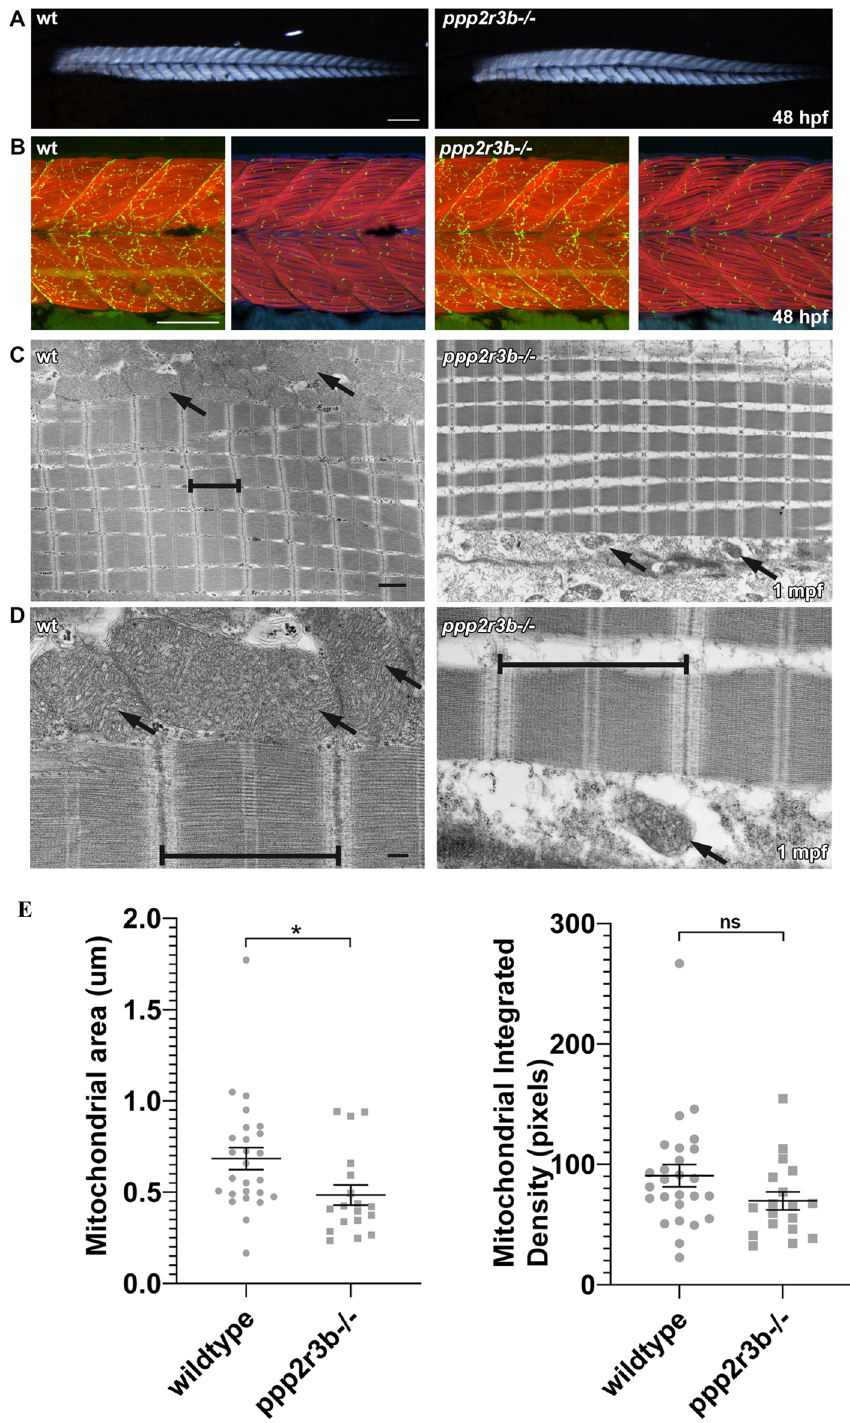
Figure 11. ppp2r3b mutants display abnormal mitochondria formation during adult stages of development, whilst muscle formation remains intact. ( A ) Skeletal muscle birefringence at 48hpf shows comparable muscle integrity between ppp2r3b mutants and wildtype siblings. Scale bar 200 µm. ( B ) Muscle fibres and motor neuron synapses appear normal in mutants compared to wildtype siblings at 48hpf, analysed by staining for F-Actin (Red) and Acetylcholine receptors (AChR, green) respectively. Left panels show a z-stack projection of F-Actin with AChR, right panels show a single focal plane of F-Actin/ AChR/DAPI. Scale bar 100 µm. ( C ) Transmission electron micrographs indicate normal sarcomeric assembly (brackets) in juvenile mutants + compared to wildtype controls, however mitochondria (arrows) are noticeably malformed and less abundant. Scale bar 1 µm. ( D ) High magnification electron micrographs showing detailed images of the sarcomeres (brackets) and mitochondria (arrows) in wildtype compared to mutant adolescent muscle samples. Scale bar 200 nm. ( E ) Quantification of mitochondrial area adjacent to sarcomeres showed a statistically significant reduction in mutants ( t- test) (n = 22 and 17 biological replicates for wild-type and ppp2r3b−/− animals,